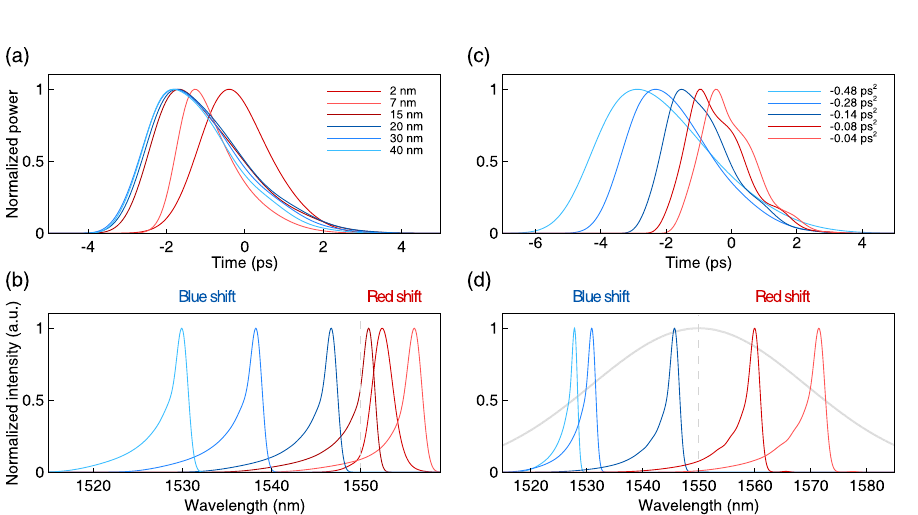
Figure 7. Temporal power distribution ( a ) and spectral power density ( b ) of the laser pulses, corresponding to spectral filters with varying bandwidth (from 2 to 50 nm) and fixed 1550 nm central wavelength (dashed gray line). Temporal power distribution ( c ) and spectral power density ( d ) of the laser pulses corresponding to varying cumulative dispersion of the laser cavity (from − 0.04 to − 0.4 ps centered at 1550 nm is shown by the gray